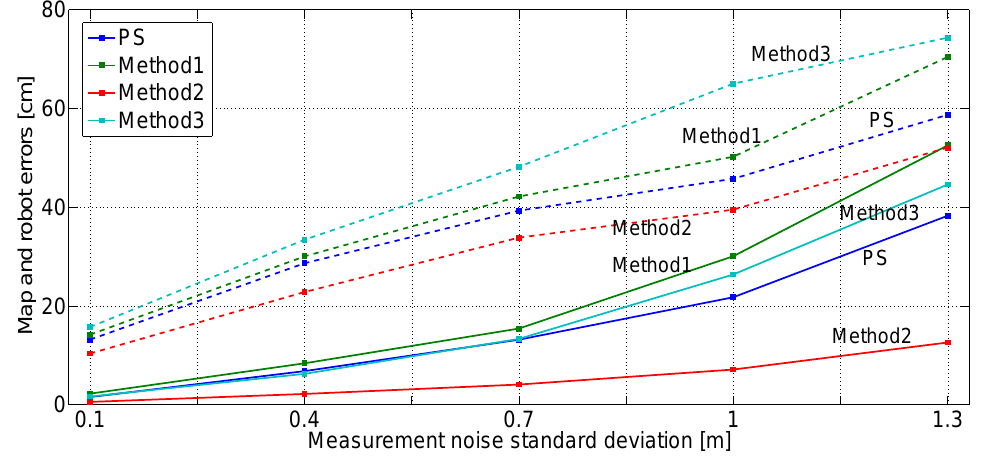
Figure 14. Robustness of Method1 , Method2 and Method3 and the proposed scheme (PS) against measurement noise level: the mean robot errors are in full lines, while the mean map errors are in dashed